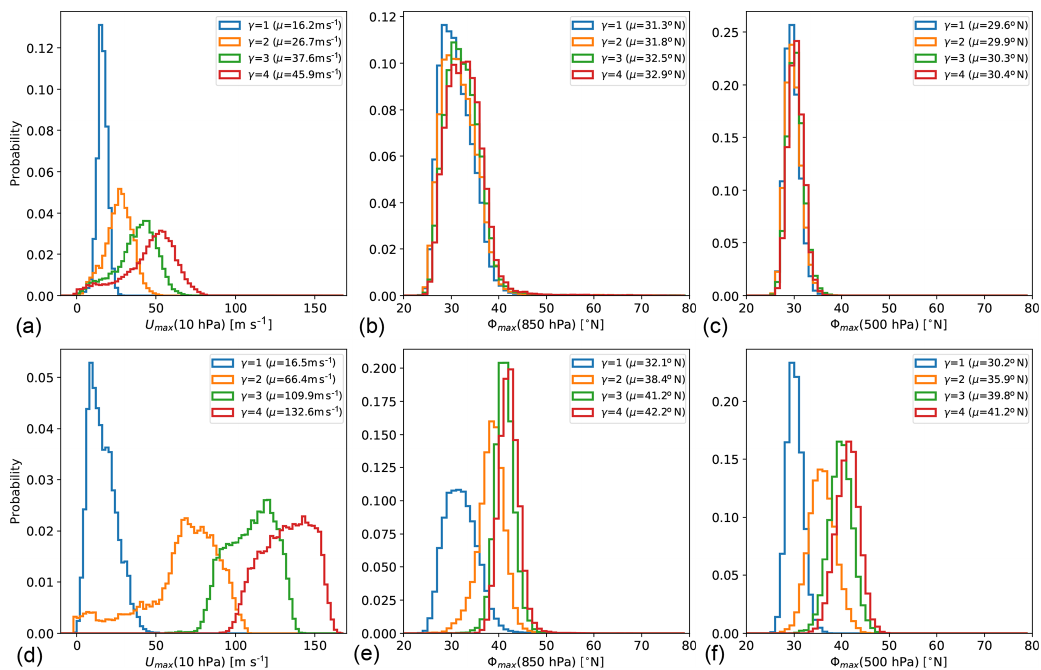
Figure C2. As Fig. C1 but for simulations with the standard PK setup and WN2 topography (a, b, c) for p Tw = 100hPa and (d, e, f) for p Tw = 400hPa.